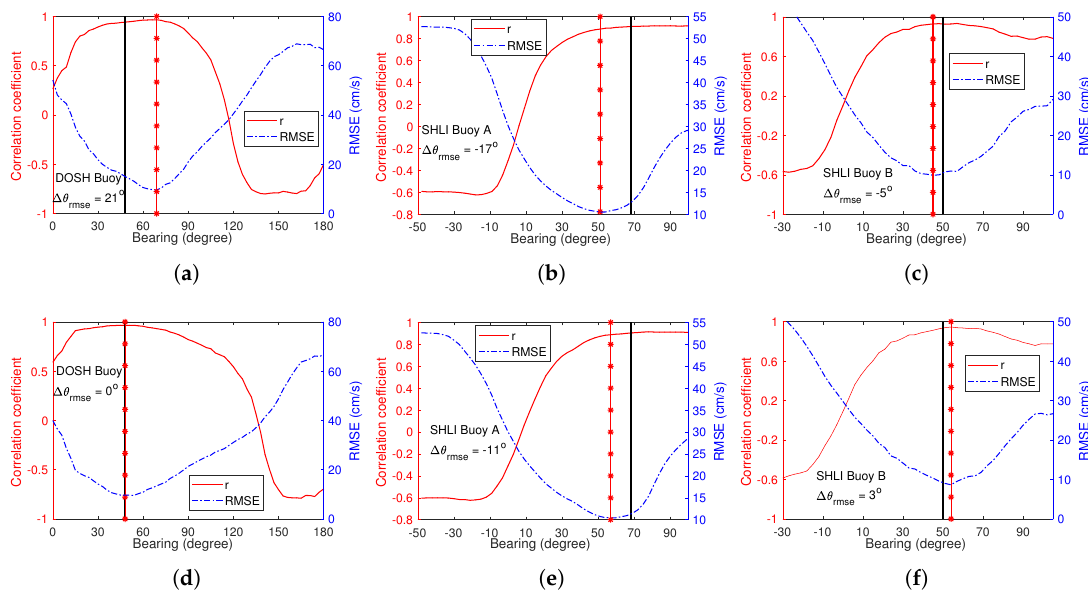
Figure 11. Correlation coefficient (r) and root-mean-square error (rmse) between radar-derived radial velocities and those derived from the buoys in a certain range cell corresponding to the buoys’ location. ( a ) DOSH–buoy comparison without calibration; ( b ) SHLI–buoy comparison at buoy A without calibration; ( c ) SHLI–buoy comparison at buoy B without calibration; ( d ) DOSH–buoy comparison with proposed calibration method; ( e ) SHLI–buoy comparison at buoy A with proposed calibration method; ( f ) SHLI–buoy comparison at buoy B with proposed calibration method. The red vertical line marked with a star indicates the bearing of the sector with minimum rmse value, and the bearing of the buoy to the radar origin is indicated by the thick black vertical line. As in [14], the bearing offset in the buoys’ direction can be quantified as the difference of the bearings indicated by these two vertical lines. All the bearings are measured as clockwise from the normal direction of the compact, three-element antenna. Table 1. The bearing offset and the ratio of the amplitude deviation of sine loop to that of cosine loop. θ m is the bearing of the buoy to the radar origin. ∆ θ urmse is the bearing offset for the uncalibrated case (Figure 11a–c). ∆ θ rmse is the bearing offset for the calibrated case (Figure 11d–f). β calid ( θ m ) is the ratio of the two loops for the calibrated case. β ucalid ( θ m ) is the ratio of the two loops for the uncalibrated case. ∆ θ is the direction-of-arrival (DOA) estimation error calculated by Equation (14) with θ 0 = θ m , α 1 ( θ 0 ) = 1, and β ( θ 0 ) = β ucalid ( θ m )